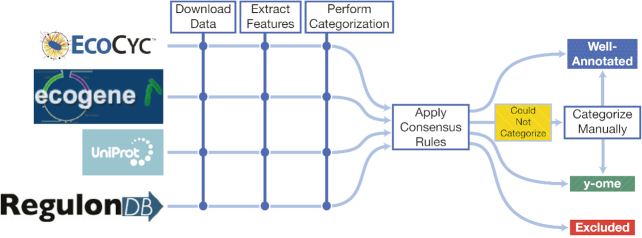
A workflow for defining the y-ome of E. coli K-12 MG1655. Data were collected from four E. coli knowledge bases, and automated categorization was applied to determine their annotation level. Next, consensus rules were applied to combine categorizations from multiple databases. When the consensus rules could not be applied, genes were manually curated and placed in one of the categories. Thus, genes were categorized as ‘Well-Annotated’ or ‘y-ome’ according to the definition of the y-ome (see Section ‘Definition of the y-ome’). Pseudogenes and phantom genes were treated separately in the ‘Excluded’ category.